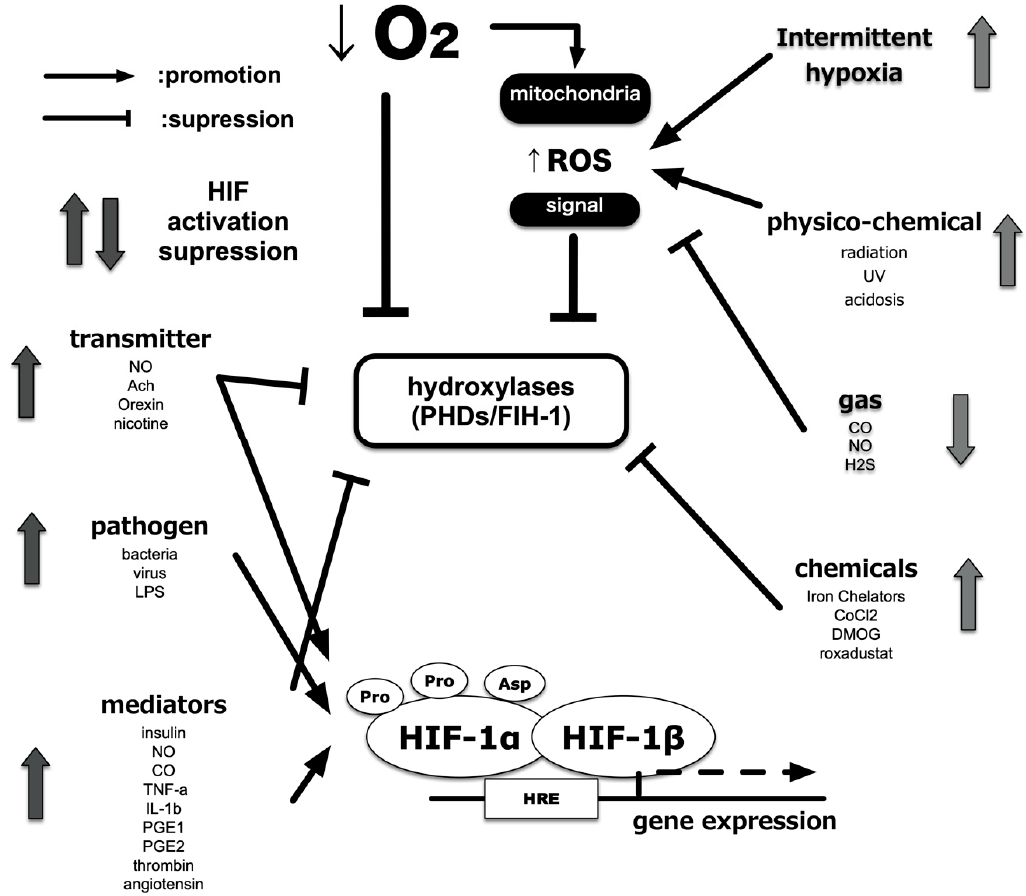
Figure 6. Alternatives to HIF activity regulation. In addition to the partial pressure of O 2 , other factors related to HIF activity have been identified. Various intracellular processes affect HIF activity independently of O 2 partial pressure and via crosstalk with low O 2 signals. In addition, certain intracellular signals result in enhanced translation of HIF-1 α protein and promote HIF-1 activation.